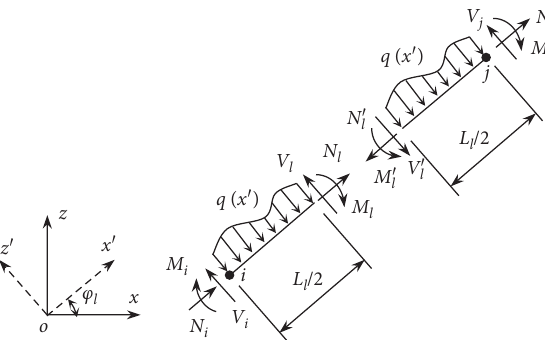
Figure 3: Free-body diagram of discrete section l of investigated